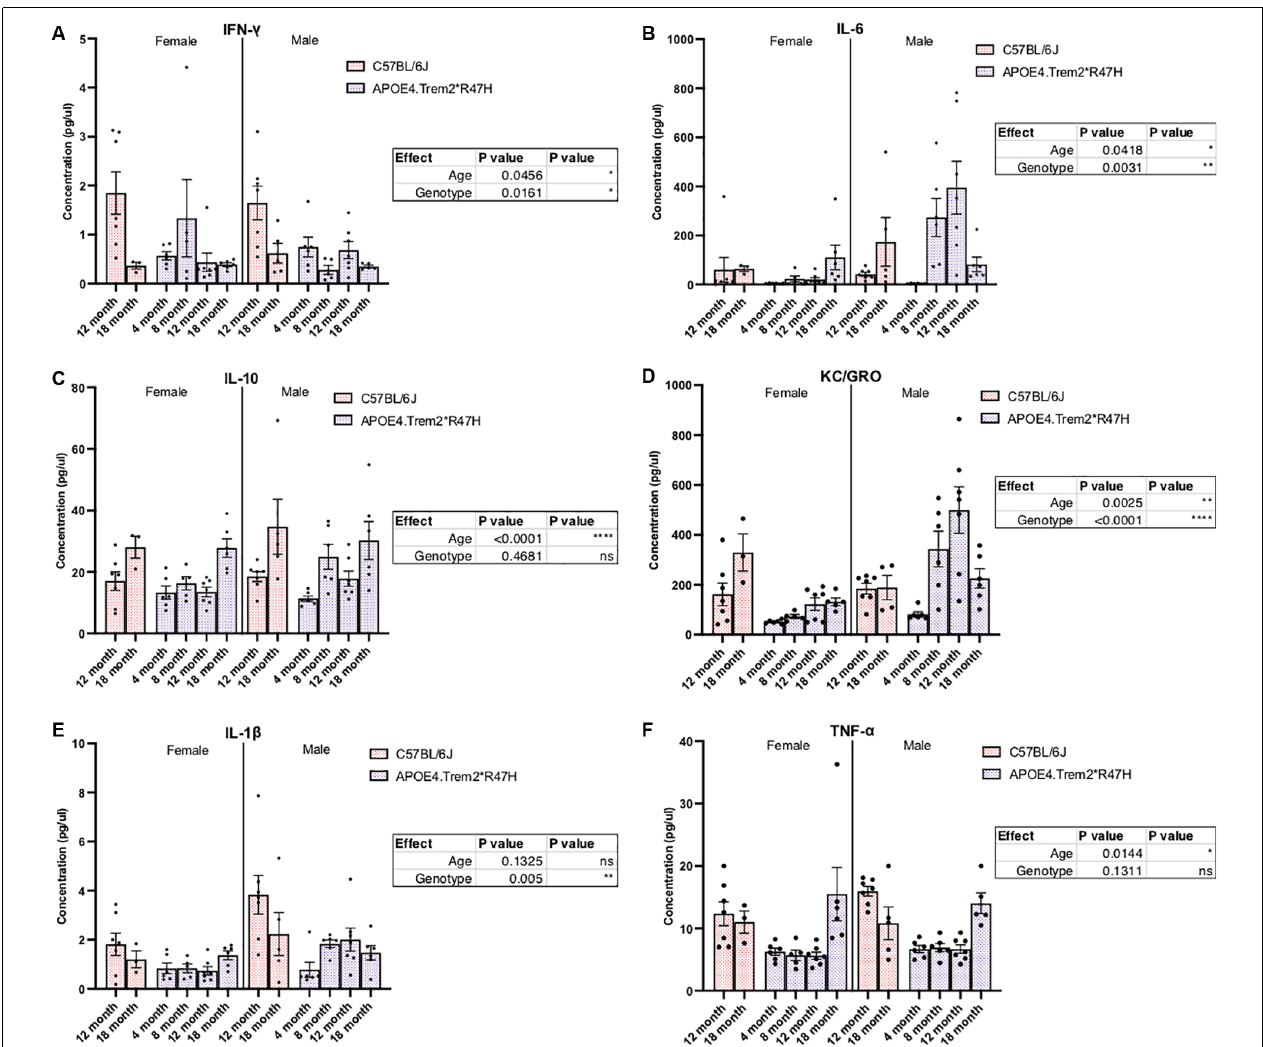
FIGURE 4 | Levels of immunomodulatory cytokines in plasma are significantly different due to increased age and combined expression of APOE4 and Trem2*R47H alleles. IFN-gamma (IFN- γ ), IL-1beta, IL-10, IL-6, and KC/GRO (CXCL1) levels were measured by multiplex immunoassays of blood plasma from C57BL/6J and B6.APOE4.Trem2R47H mice (A–F) . Genotype- and age-dependent differences determined by two-way ANOVA. Factor effects displayed in tables. ∗ p < 0.05; ∗∗ p < 0.01; ∗∗∗ p < 0.001. All alleles expressed were homozygous.